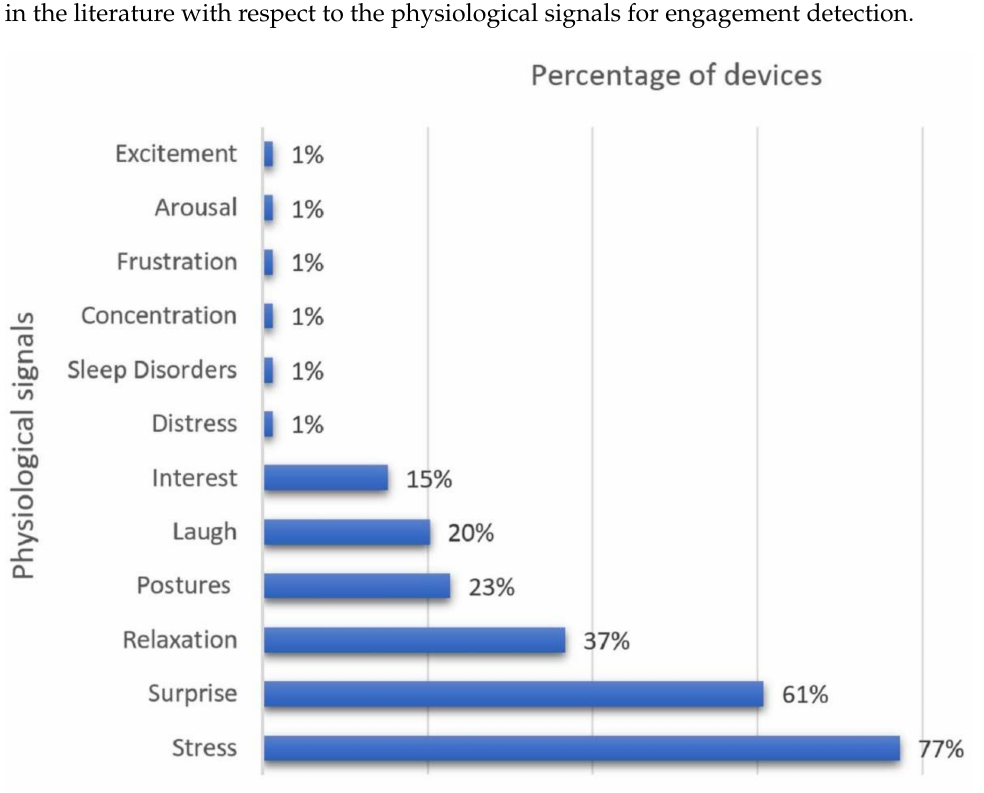
Figure 6. Correspondence between Commercial Wearables and Physiological Signals for Engage- ment